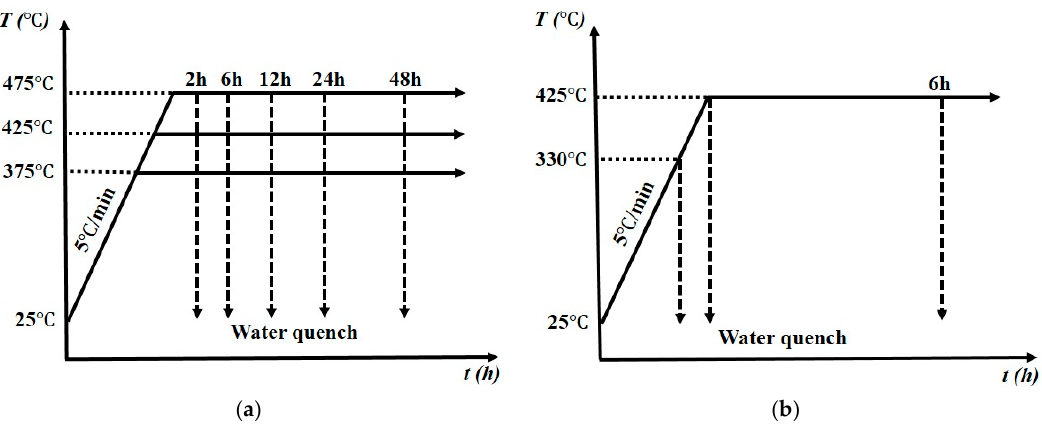
Figure 1. The schematic diagram of two heat treatment conditions: ( a ) for the precipitation of dispersoids and ( b ) for the dispersoid nucleation.